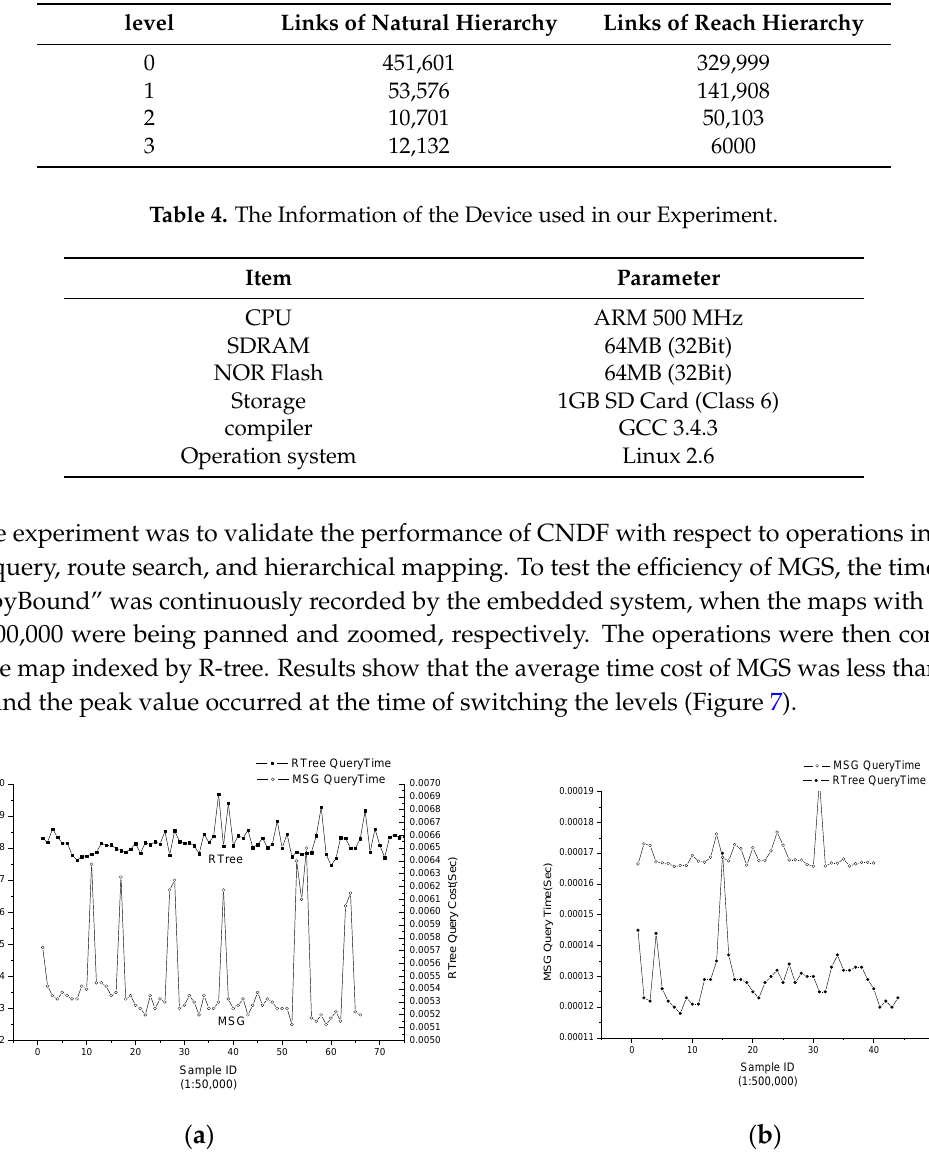
Figure 7. The time cost of “QuerybyBound” during ( a ) map pan and ( b ) zoom.